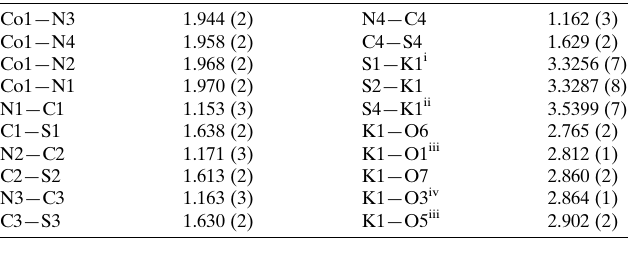
Table 2 Hydrogen-bond geometry (A˚ , (cid:5) ).